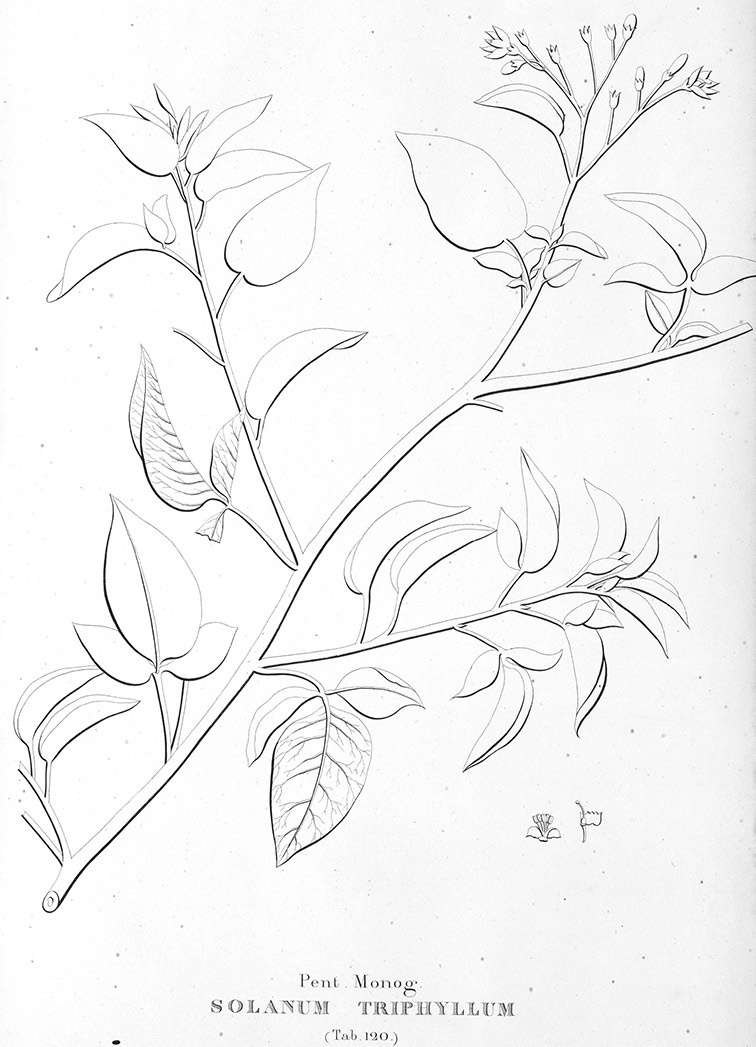
Lectotype of Solanum triphyllum Vell. (Vellozo 1831: tab. 120). Reproduced with permission of the Natural History Museum Botany Library.